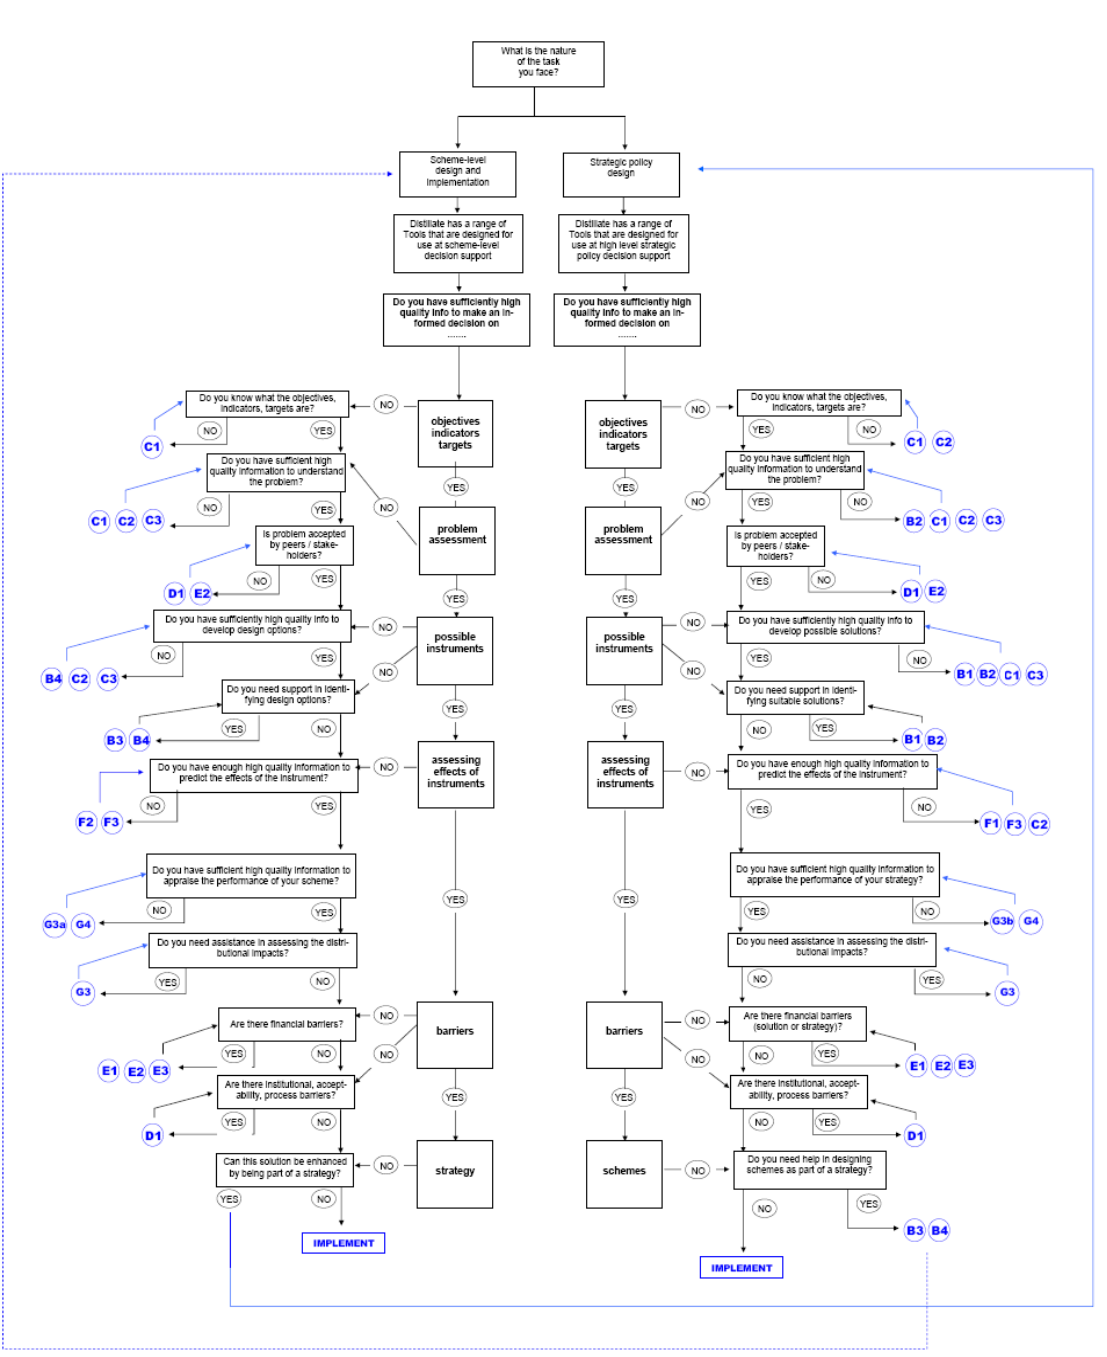
Figure 2. the ‘flowchart’ or ‘decision tree’ structure of the online tool (Figure prepared by David Watkins of Heriot Watt